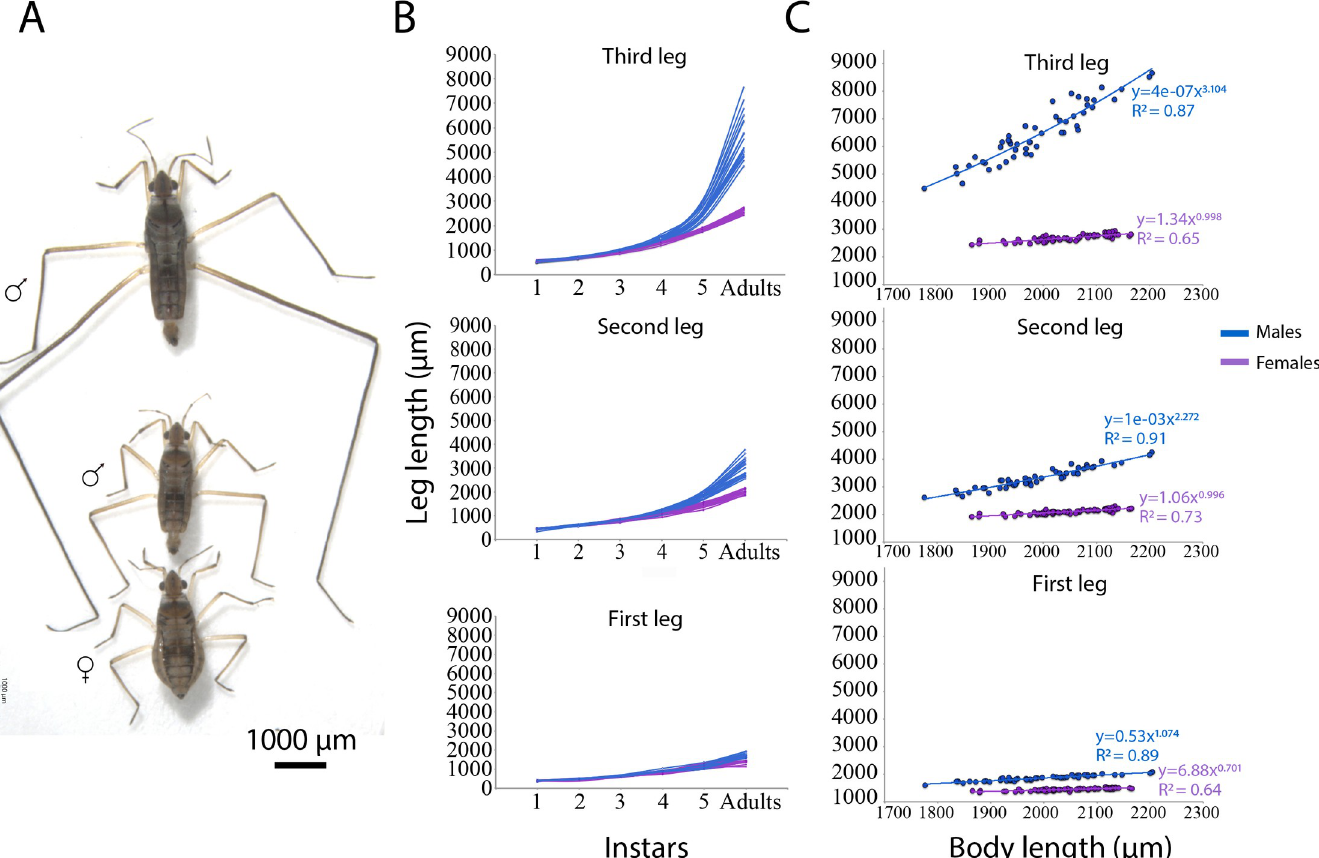
Fig 1. Growth dynamics of male exaggerated third legs in M . longipes . (A) Adult large and small males and a female showing final growth phenotypes. (B) Leg length variation during postembryonic development (nymphal development) in males and females. Each line represents leg growth dynamics of a single individual during nymphal development until adulthood. (C) Static allometries between body length and the 3 pairs of legs in adult males and females. Power law regressions were fitted to the raw data to represent the static allometric equation y = bx a . Differences in static allometry parameters were tested on log-transformed data in [19]. The data underlying this figure may be found in S1 and S2